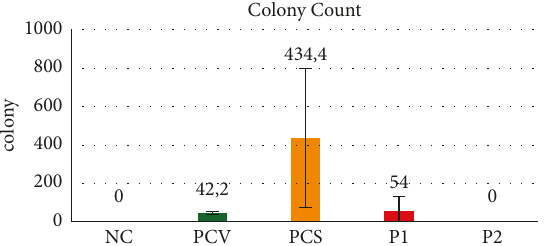
Figure 5: The graph of the number of colony-forming units in the five